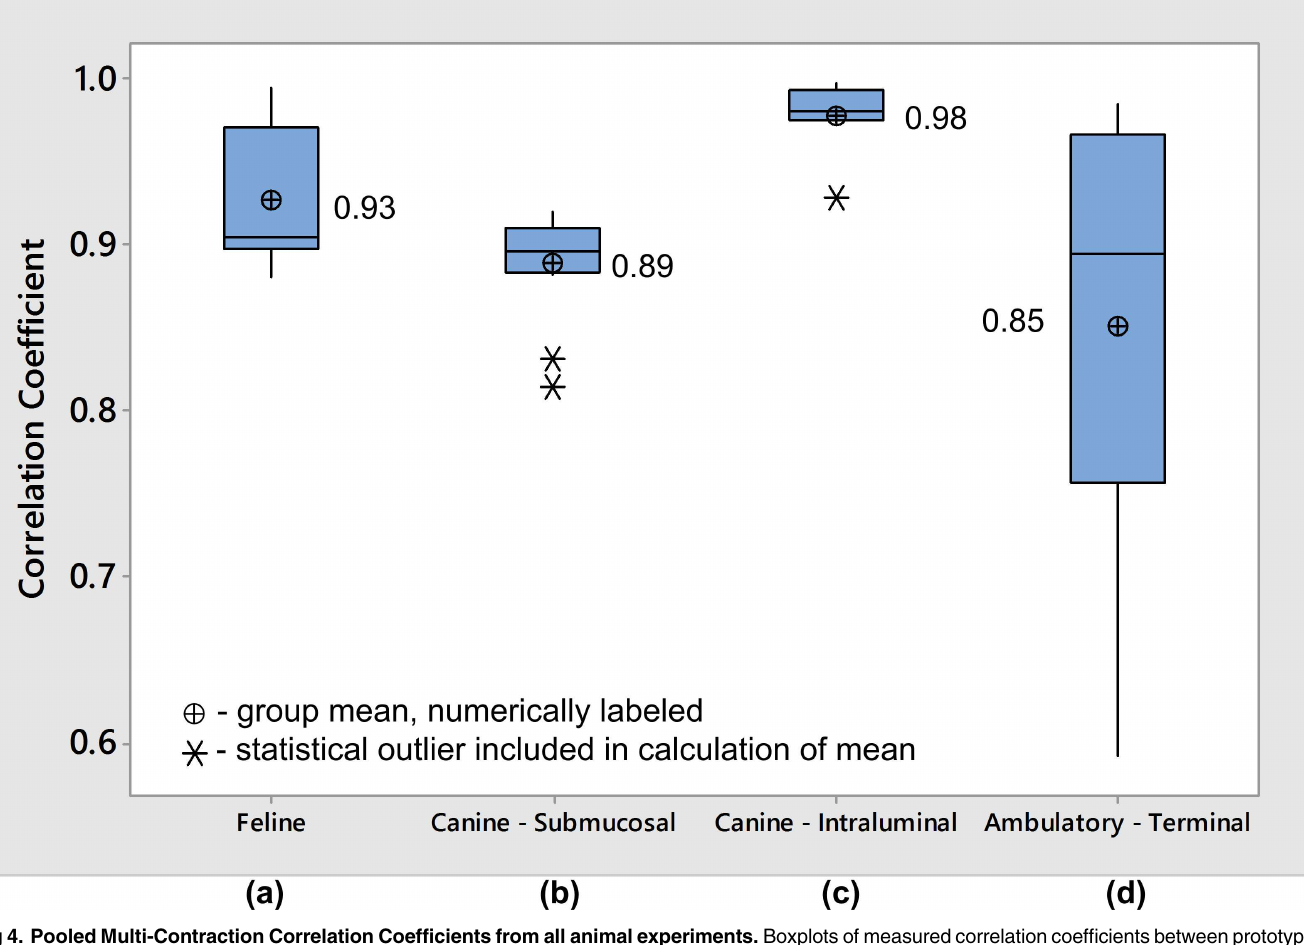
Fig 4. Pooled Multi-Contraction Correlation Coefficients from all animal experiments. Boxplots of measuredcorrelationcoefficientsbetweenprototype device and reference catheter in (a) anesthetized feline with submucosal device placement, (b) anesthetized caninewith submucosal device placement, (c) anesthetized caninewith intraluminal device placement,and (d) anesthetized canine terminalprocedurewith intraluminaldevice placementafter 10-day implantperiod. Each box represents correlationcoefficients obtainedfrom 9–16 ten second recordingwindowscomparingprototypedevice and reference catheter measurements. The box width depicts the interquartile range of measuredcorrelationcoefficients, whilethe box whiskersrepresent the full range of measureddata after excludingstatistical outliersidentifiedwith Peirce’s criterion. The central line within each box represents the median,and the data mean is indicatedwith a cross symbol. Raw data is shown in S1 Table